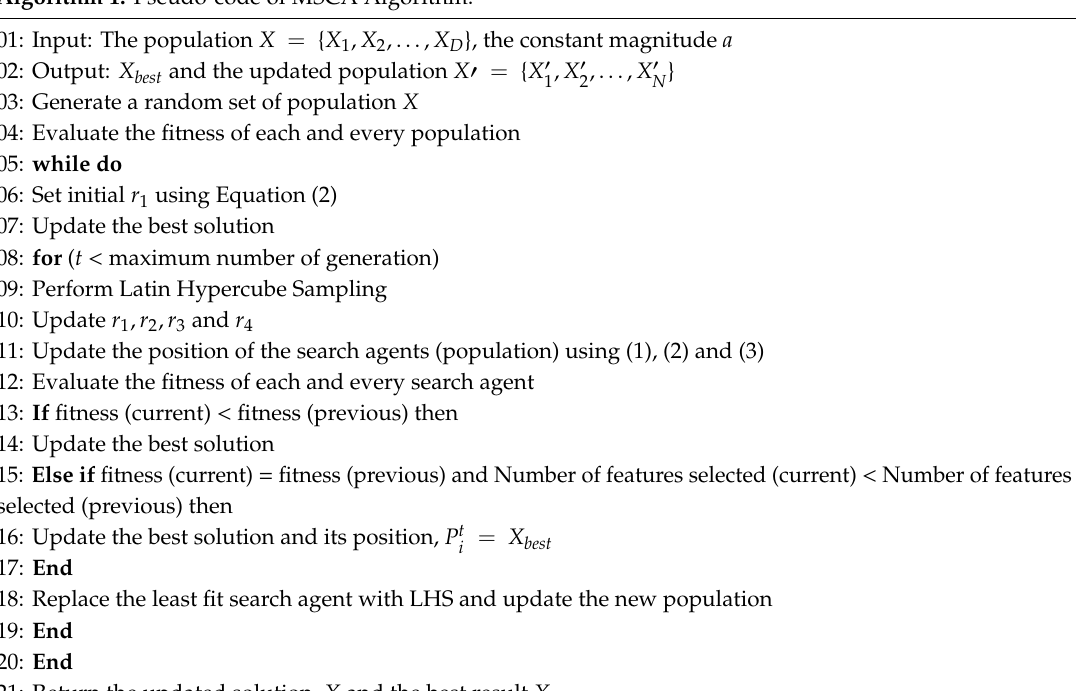
Algorithm 1. Pseudo-code of MSCA Algorithm.